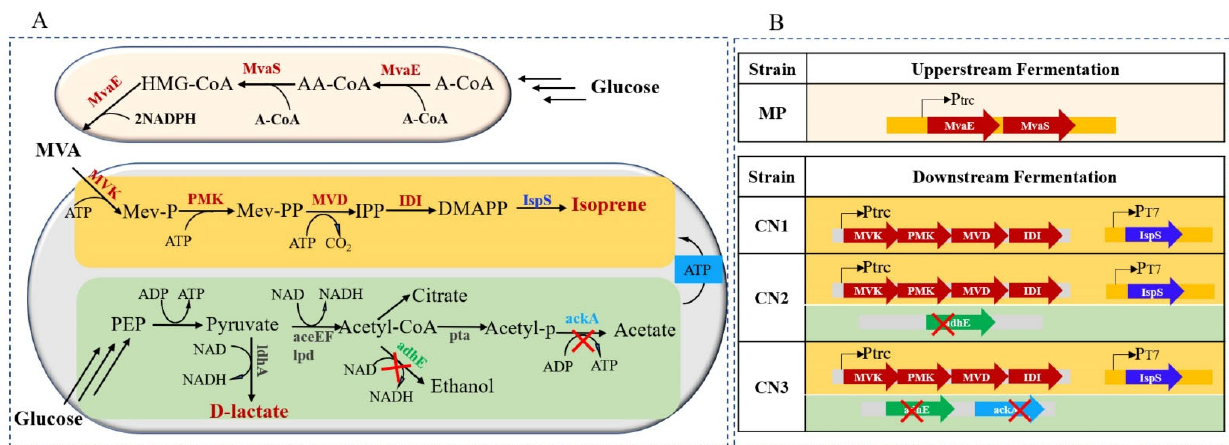
Figure 1. The metabolic pathway and strain information for the co-production of isoprene and lactate: ( A ) Mevalonate (MVA) is produced by the upstream fermentation from glucose; isoprene and lactate are co-produced by the downstream fermentation from MVA and glucose substrates. ( B ) Construction of the co-production strains carrying the downstream genes of the MVA pathway and deleting the genes of ackA and adhE . Enzymes involved in this pathway—MvaE: acetyl-CoA acetyltransferase/HMG-CoA reductase; MvaS: HMG-CoA synthase; MVK: mevalonate kinase; PMK: phosphomevalonate kinase; MVD: mevalonate pyrophosphate decarboxylase; IDI: IPP isomerase; IspS: isoprene synthase; aceEF: pyruvate dehydrogenase; lpd: lipoamide dehydrogenase; adhE: alcohol/aldehyde dehydrogenase; pta: phosphate acetyltransferase; ackA: acetate kinase. Pathway intermediates—A-CoA: acetyl-CoA; AA-CoA: acetoacetyl-CoA; HMG-CoA: